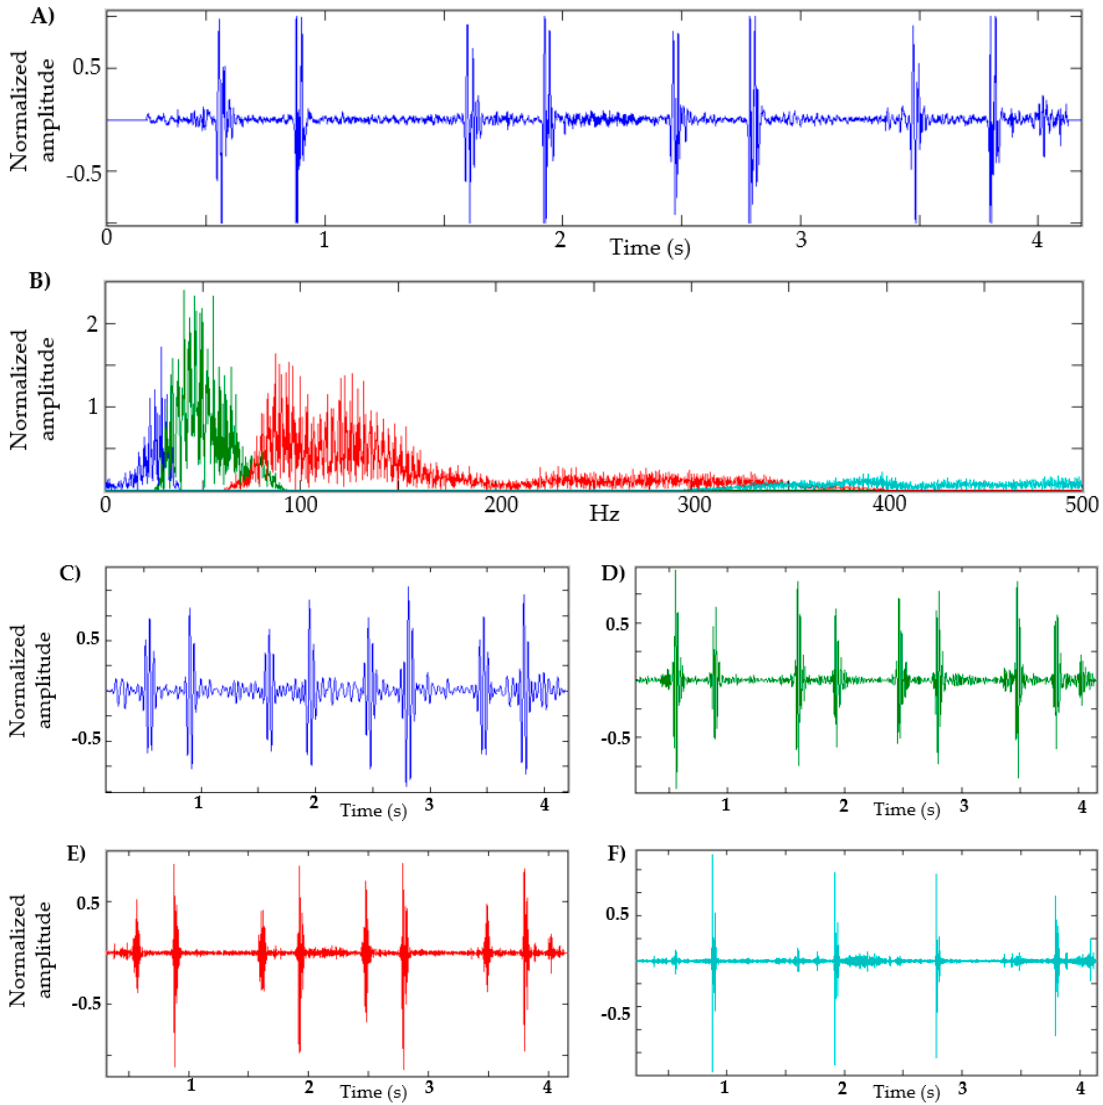
Figure 2. Decomposition of heart sound using EWT. ( A ) Heart sound recording; ( B ) FFT of heart sound with the frequency bands determined; ( C ) EWT components defined between 1–40 Hz. ( D ) EWT components defined between 40–80 Hz. ( E ) EWT components defined between 80–350 Hz. ( F ) EWT components defined at 350 Hz and above.